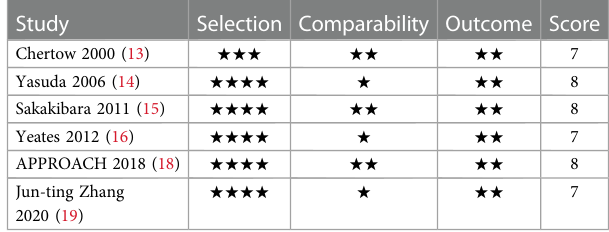
TABLE 1 Quality assessment of